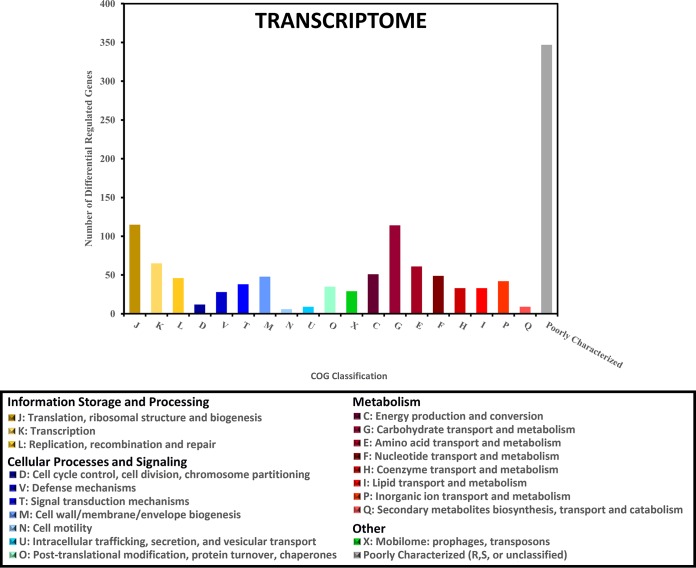
Characterization of differentially expressed genes based on their COG classification. Genes that were determined to have a significant 2-fold difference in expression between at least one biofilm time point and one planktonic time point were categorized based on their COG classification. The numbers of genes in each COG classification are shown for the 1,039 genes with differential expression based on transcriptome data. Letter designations refer to the standard COG abbreviations. Numbers sum to greater than 1,039 due to some genes fitting in two or more COG classifications. The “Poorly Characterized” group includes COG classifications R (general function prediction only) and S (unknown function) in addition to unclassified genes.